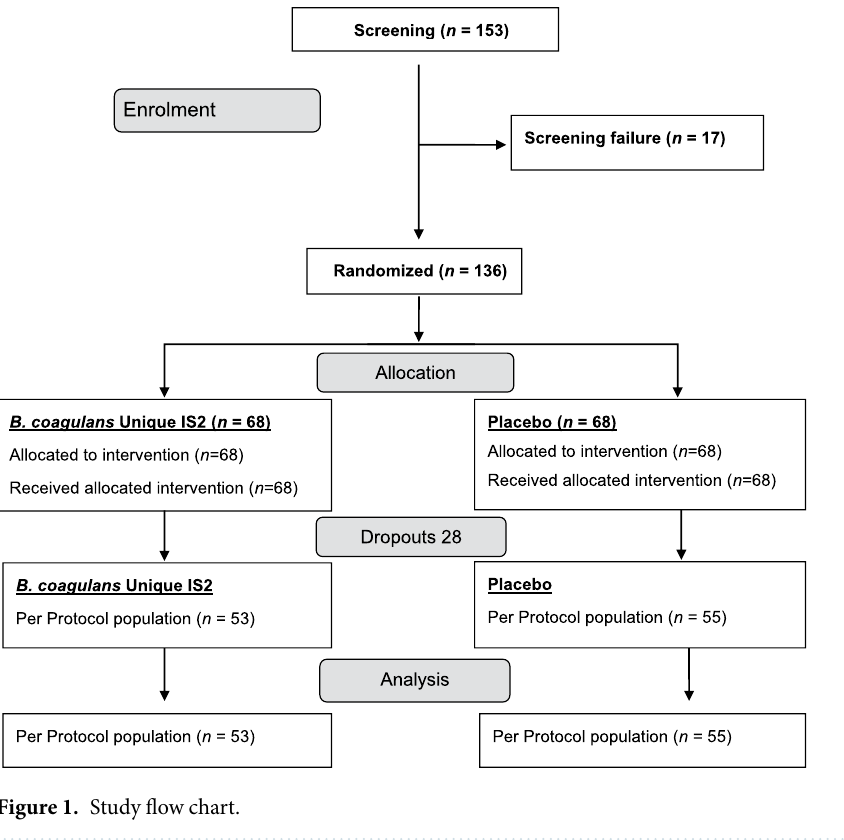
Figure 1. Study flow